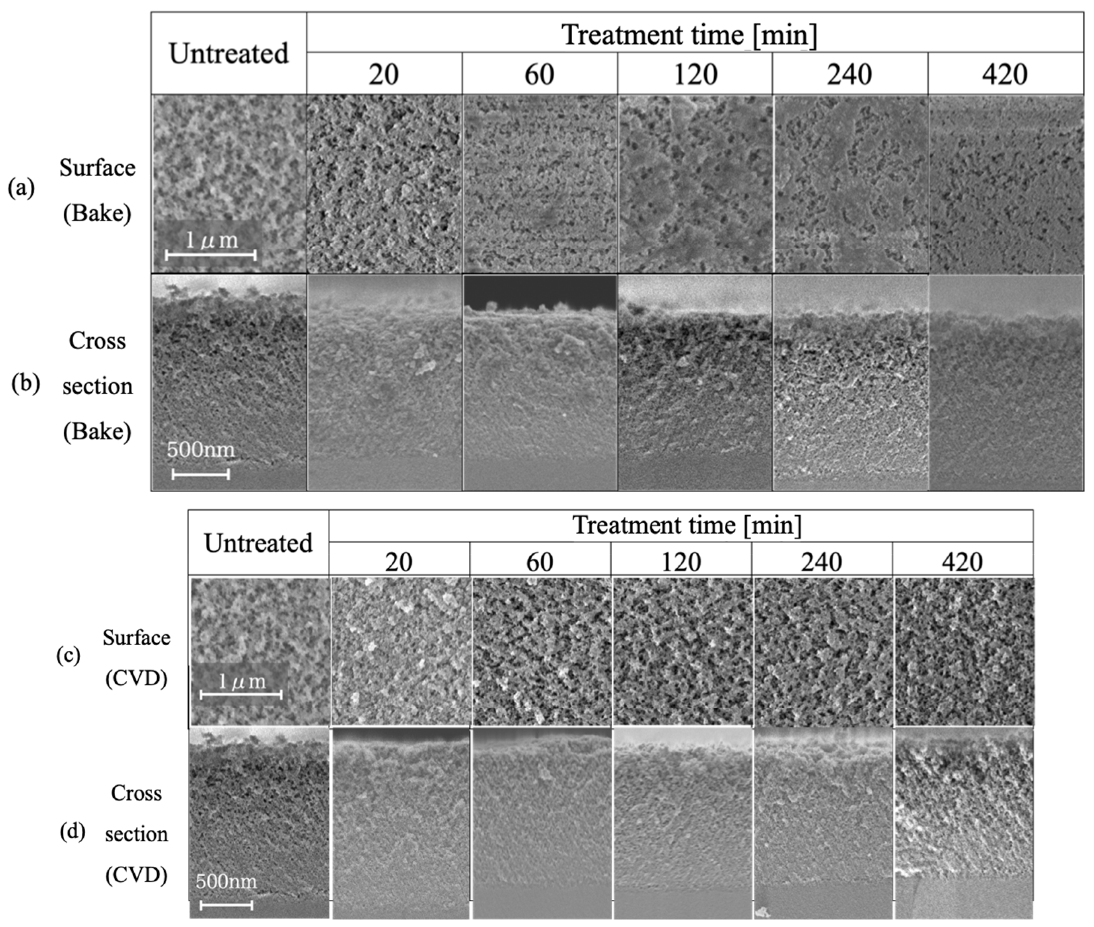
Figure 6. SEM micrographs of ( a ), ( b ) the PDMS-baked HNL glass and ( c ), ( d ) the CVD-treated HNL glass. The surface view ( a , c ) and cross-sectional view ( b , d ) indicate that the HNL was not filled by PDMS other than most of the surface area.